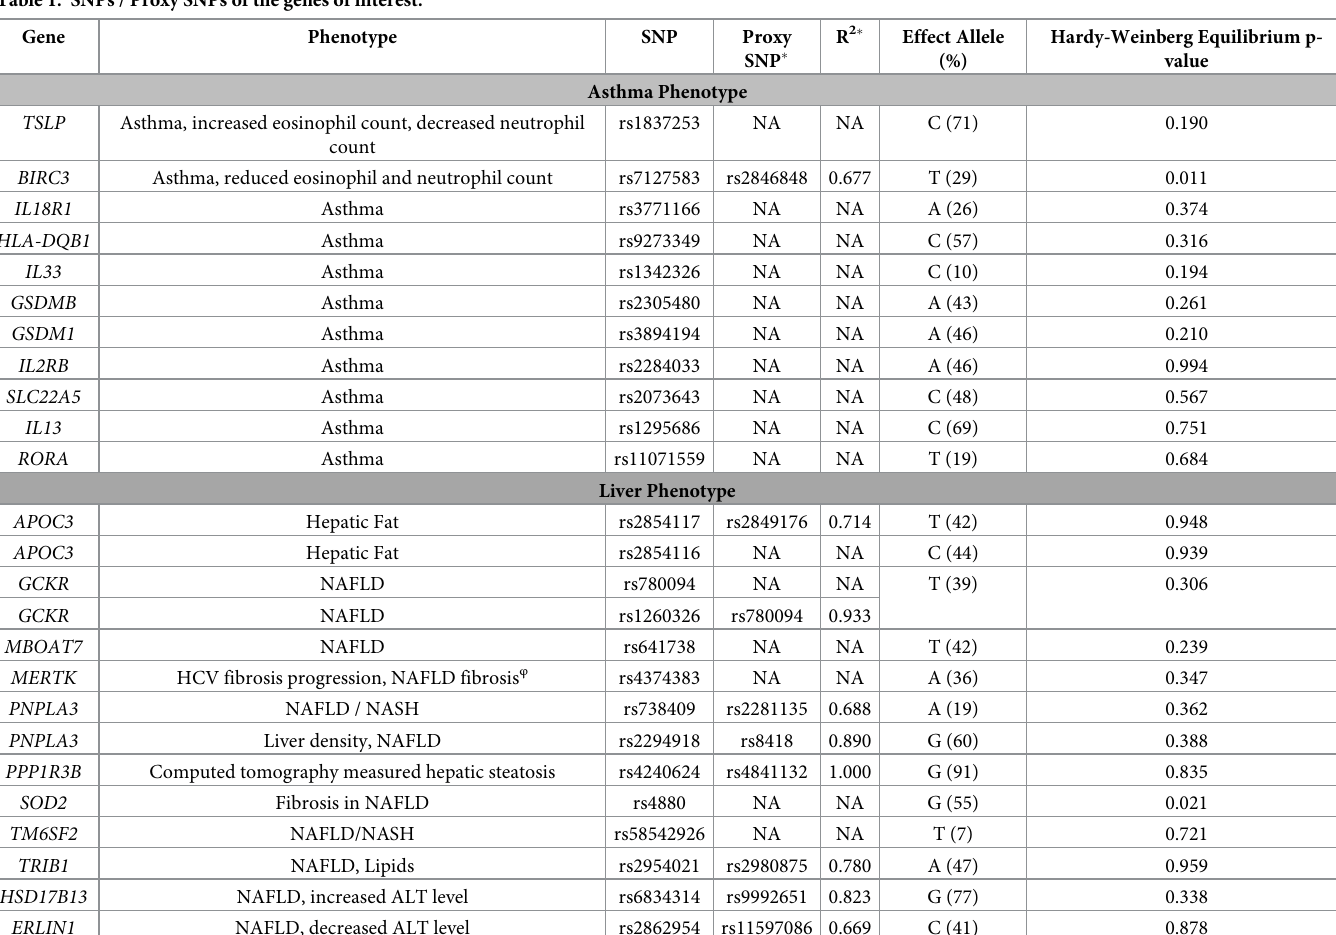
Table 1. SNPs / Proxy SNPs of the genes of